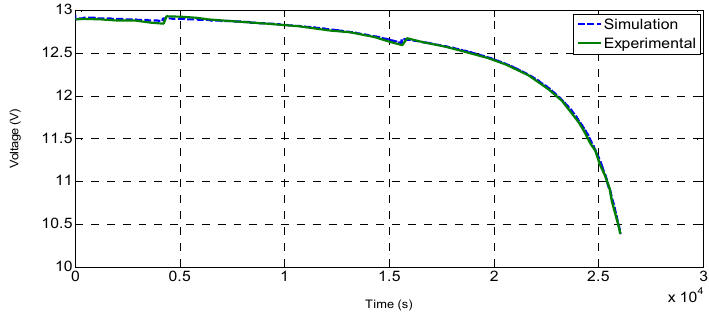
Figure 9. The discharge voltage as a function of time at variable C-rates. The evolution of estimated SOC under the influence of variable C rates is depicted in Figure 10. It can be observed that the battery is initially fully charged (SOC0 = 100%) and the battery charging status decreases after 7.23 h to its minimum threshold (SOC = 20%), corresponding to the recommended value of the lead–acid battery (SOC min = 20%). Again, this value must not exceed to prevent the battery from being permanently damaged. Fur- thermore, the theoretical estimation matches the experimental findings.